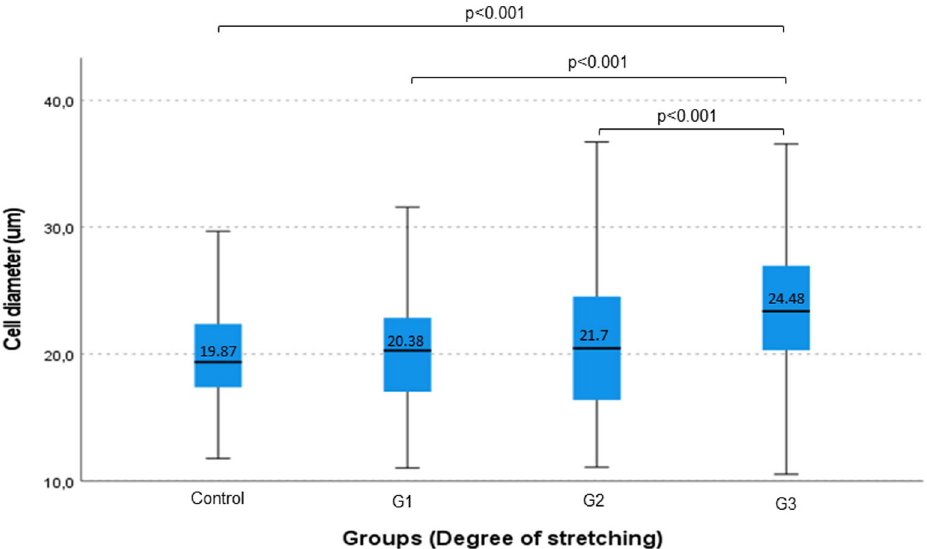
Figure 7. Diameter of the muscle cells. Boxplot diagram showing the measured cell diameters of the four Groups and the observed significant difference by paired comparisons of the Groups.